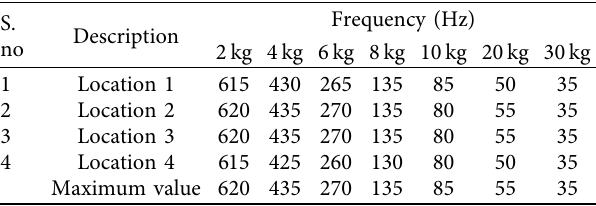
Table 8: Frequency under loading condition for Mg alloy (with 4 location